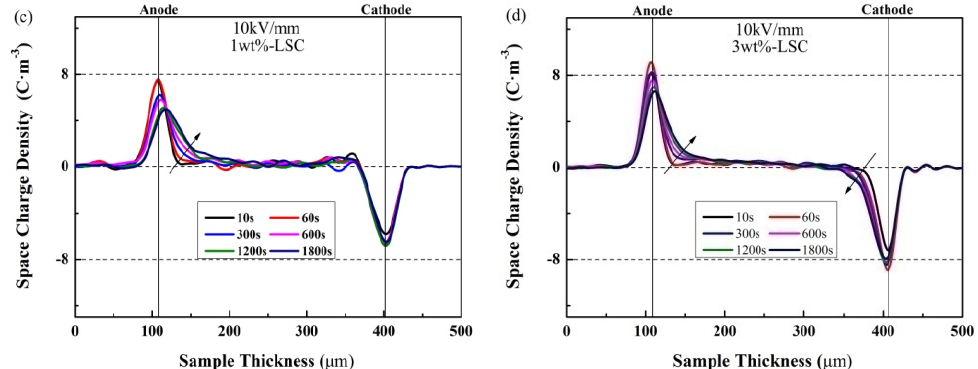
Figure 12. Space charge distribution of LDPE when the composite with different LSC contents acts as a semiconductive layer under 10 kV/mm DC electric field.